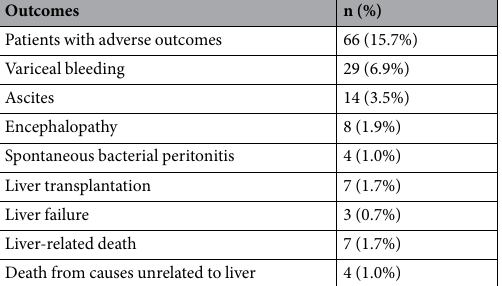
follow-up period or before death. An endoscopic intervention was performed for 8 patients, and TIPS was per- formed for 5 patients to treat variceal bleeding. Nevertheless, 4 cases died in the hospital, even after treatment with the combination of vasoactive agents and surgeries described above. Ascites (moderate to large) was diag- nosed in 14 cases at the follow-up assessment, encephalopathy was diagnosed in 8 cases, and SBP was diagnosed in 4 cases. Liver transplantation (LT) was performed for 7 patients (6 women and 1 man) from 2001 to 2016, and the median duration was 36 months. Eleven patients died of adverse events due to cirrhosis or extrahepatic diseases. Of these deaths, 7 were cirrhosis-related; the causes of death were variceal bleeding (n = 4), encephalopathy (n = 2) and liver failure (n = 1). The extrahepatic diseases that caused patient deaths were cerebral infarction (n = 1), ovarian cancer (n = 1), pulmonary interstitial fibrosis (n = 1) and severe pulmonary infection (n = 1; Table 3). Importantly, the patients who died from pulmonary infection did not present with signs of cirrhosis at death. Figure 3 (panel A) shows the long-term prognosis of non-cirrhotic PBC and cirrhotic PBC on presentation, which had esti- mated mean survival times of 145.1 months and 104.5 months, respectively (95%CI: 136.9–153.3 months and